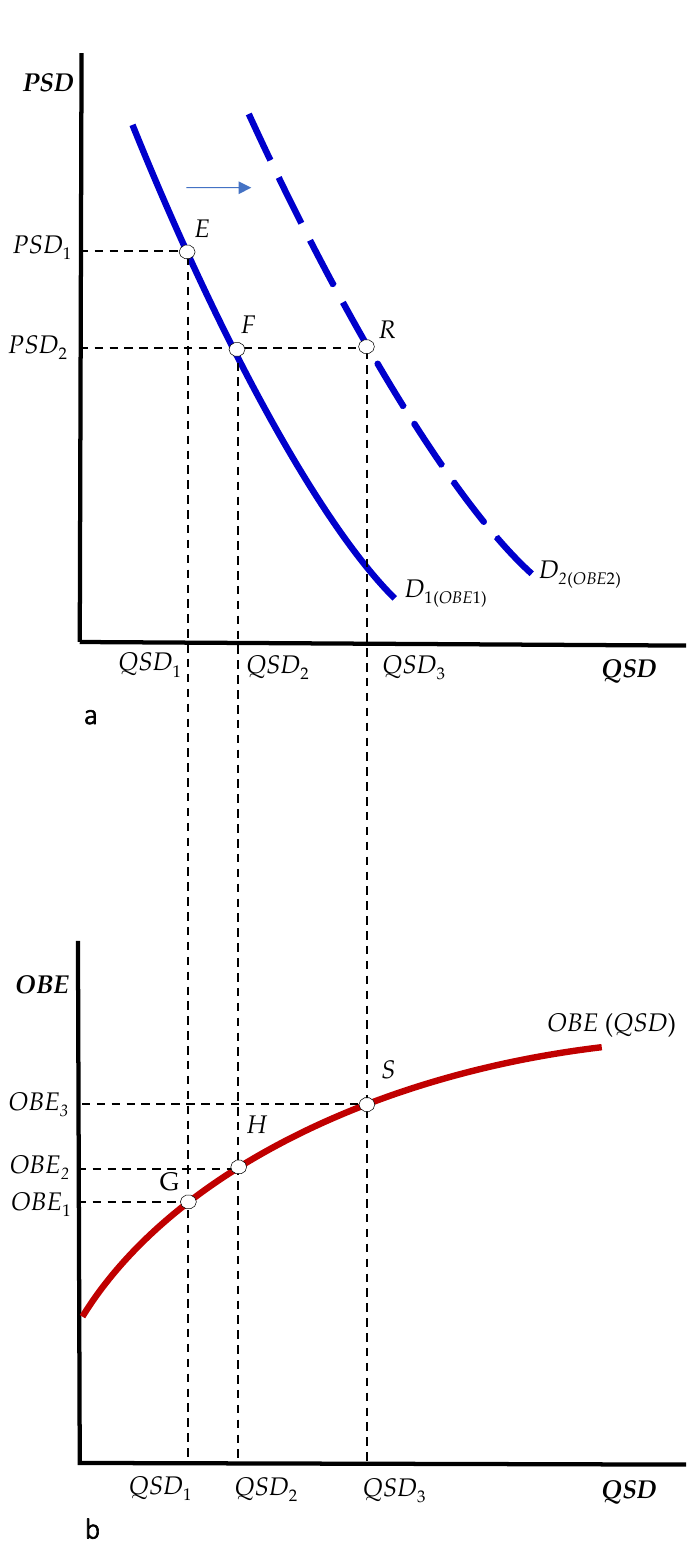
Figure 2. ( a ) The impact of the prevalence of obesity on the market demand for soft drinks, ( b ) The impact of soft drink consumption on the prevalence of obesity. Note: QSD , soft drink consumption per capita (liters/person/year); PSD , soft drink price (average price per liter, constant 2017 interna- tional $); OBE , prevalence of obesity (BMI ≥ 30 kg/m 2 . Age-stand. rate, both sexes, 18+ years, %) . At price PSD 1 , the quantity demanded is QSD 1 (point E in Figure 2a), implying a prevalence rate of obesity equal to OBE 1 (point G in Figure 2b). A decrease in price from PSD 1 to PSD 2 —due, for instance, to an aggressive pricing strategy which reflects greater competition among producers and/or distributors—leads to an increase in the quantity demanded to QSD 2 (i.e., a movement along the D 1 curve until point F ), which results in a greater prevalence of obesity ( OBE 2 , point H in Figure 2b). However, OBE 2 is not the final equilibrium because this greater spread of obesity increases the demand for soft drinks (i.e., the entire demand curve shifts to the right, from D 1 to D 2 in Figure 2 a ). That is, at